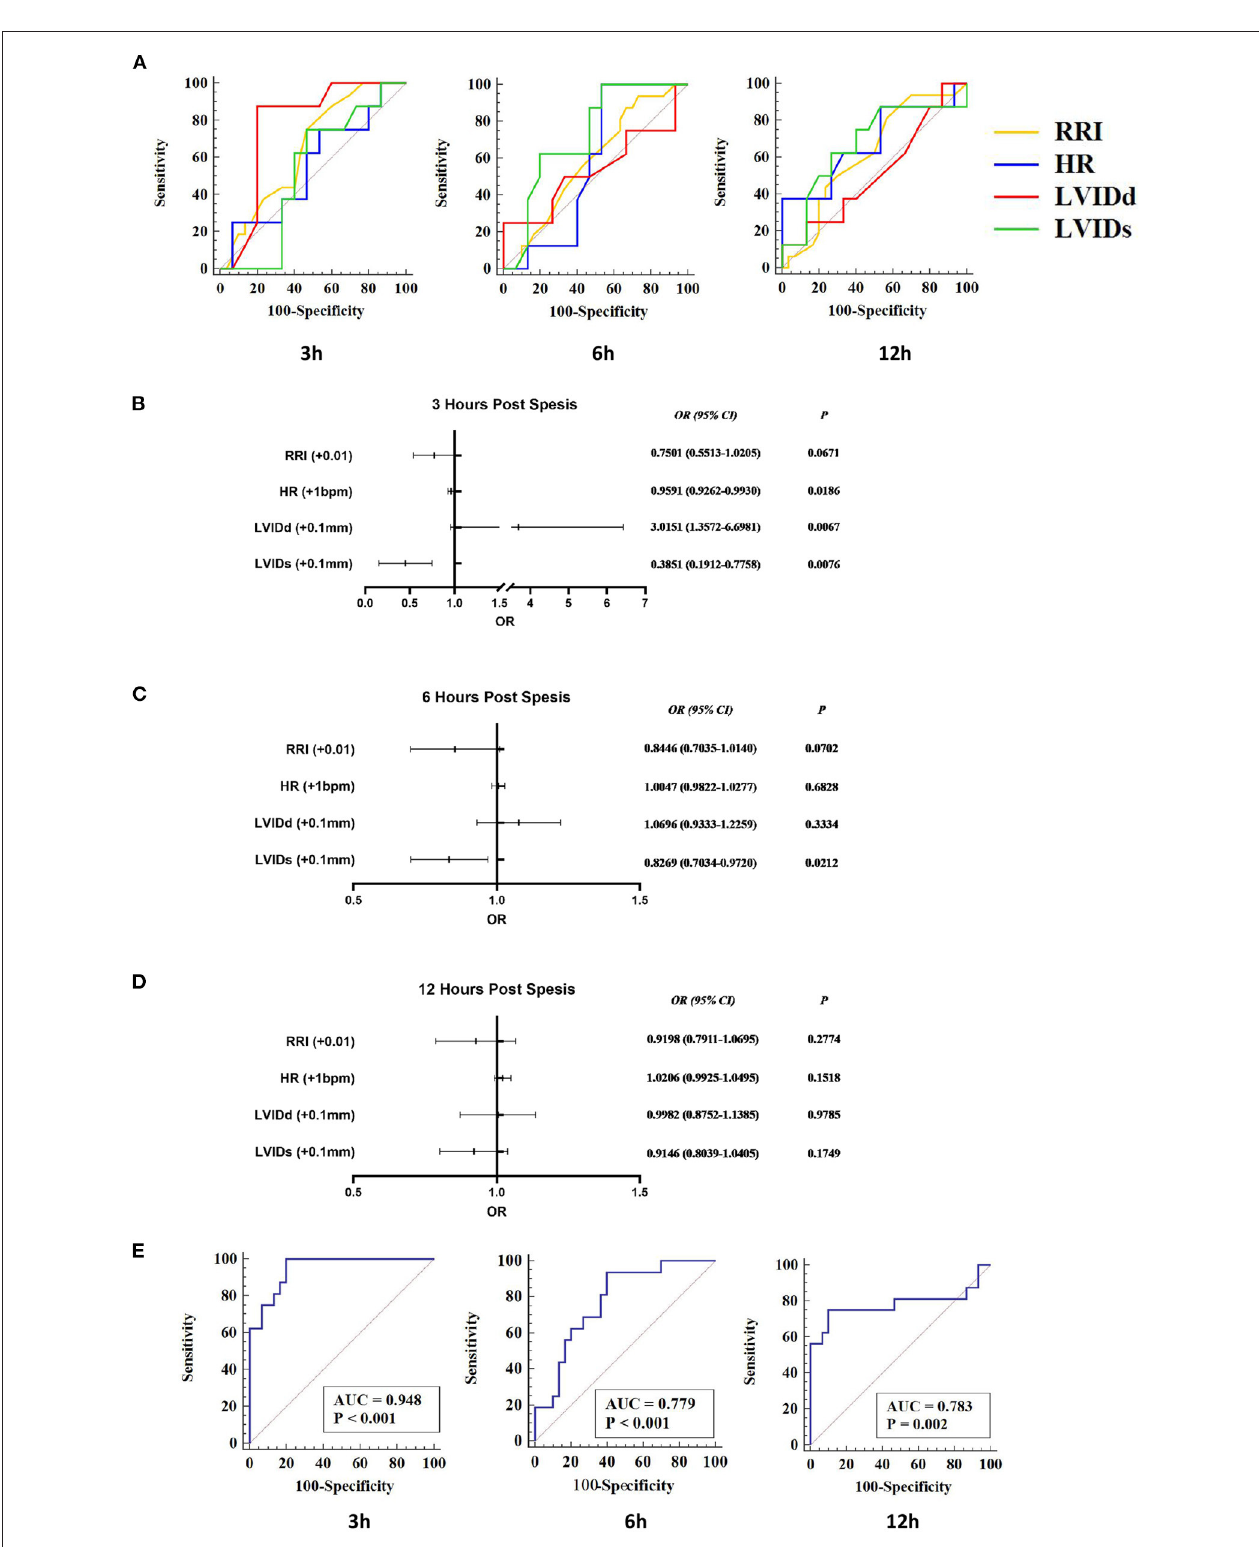
FIGURE 5 | RRI combined with echocardiographic parameters to predict S-AKI. RI, HR, LVIDd, and LVIDs were included in the logistics regression analysis to explore the joint predictive value of S-AKI. (A) Receiver-operating characteristic (ROC) curve of RRI, HR, LVIDd, and LVIDs at 3h (Left), 6h (Middle), and 12h (Right). At 3h, only LVIDd had a predictive value for AKI (AUC = 0.771, 95% CI 0.623–0.882, P < 0.001). At 6h, only LVIDs had a predictive value for AKI (AUC = 0.725, 95%